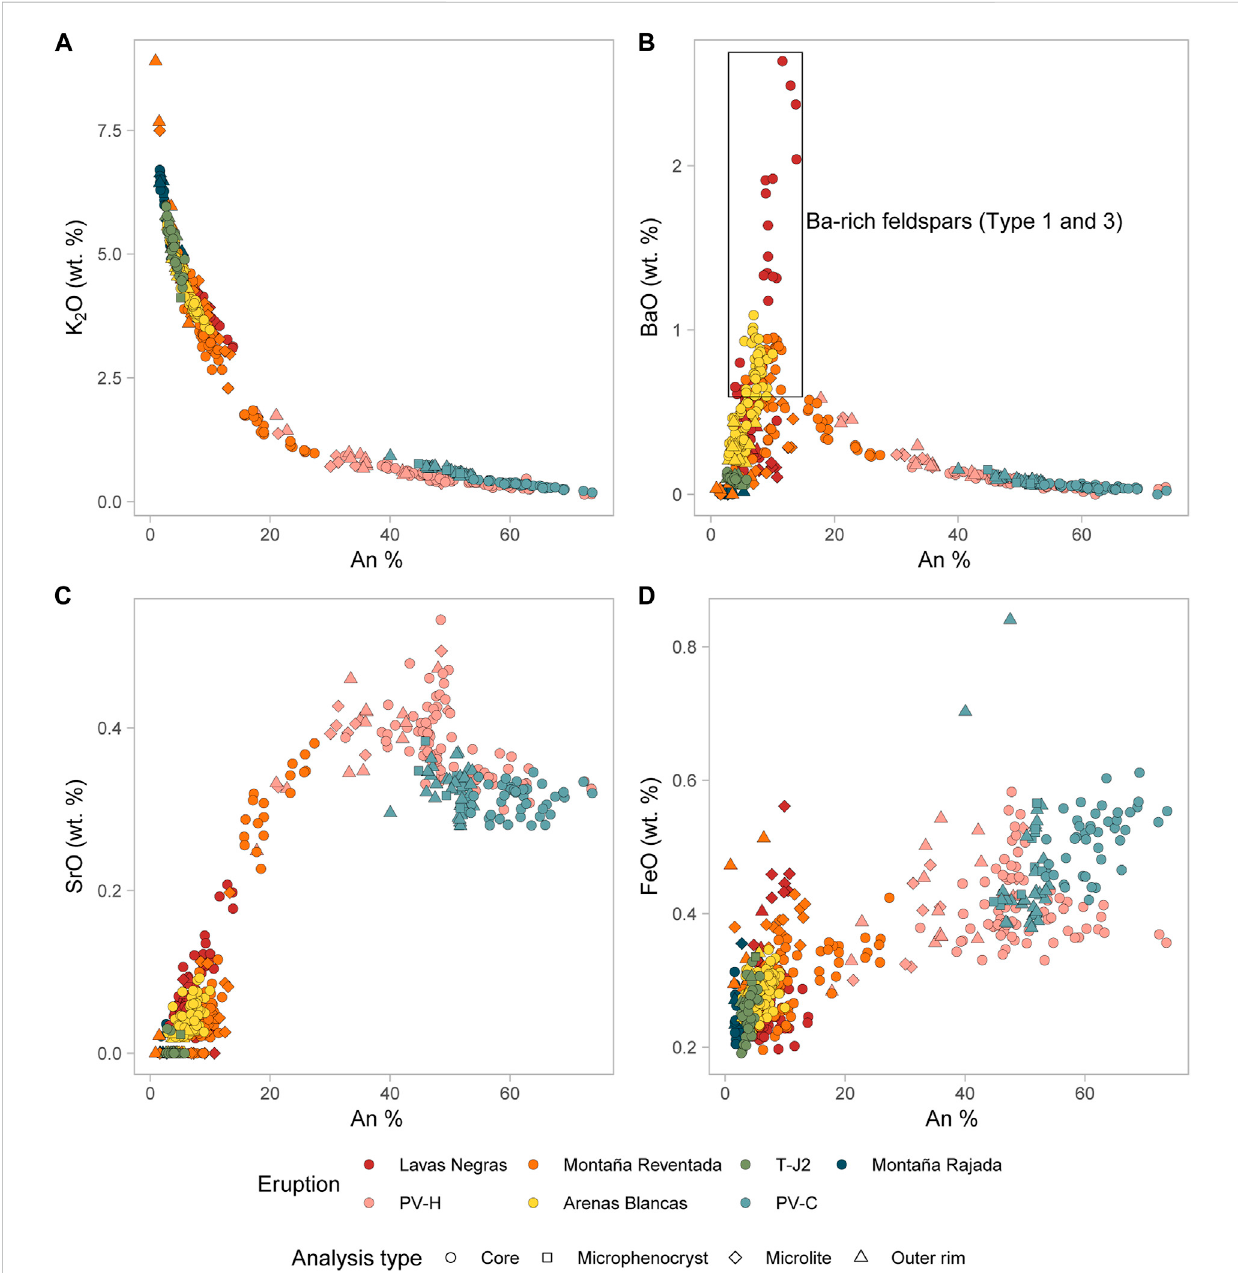
FIGURE 6 Diagrams showing K 2 O (A) , BaO (B) , SrO (C) , and FeO (D) covariations with An (in wt%) in the studied feldspars (normalized to 100%) obtained by EPMA. Symbols represent the type/zone of the mineral analysed: “ Core ” , phenocryst core; “ Outer rim ” phenocryst outer rim or outermost transect point inthecaseofnodistinctrim; “ Microphenocryts ” forcrystalswithaclearlysmallersizethanthemainpopulationandahomogenouscomposition.Colours indicate feldspar host